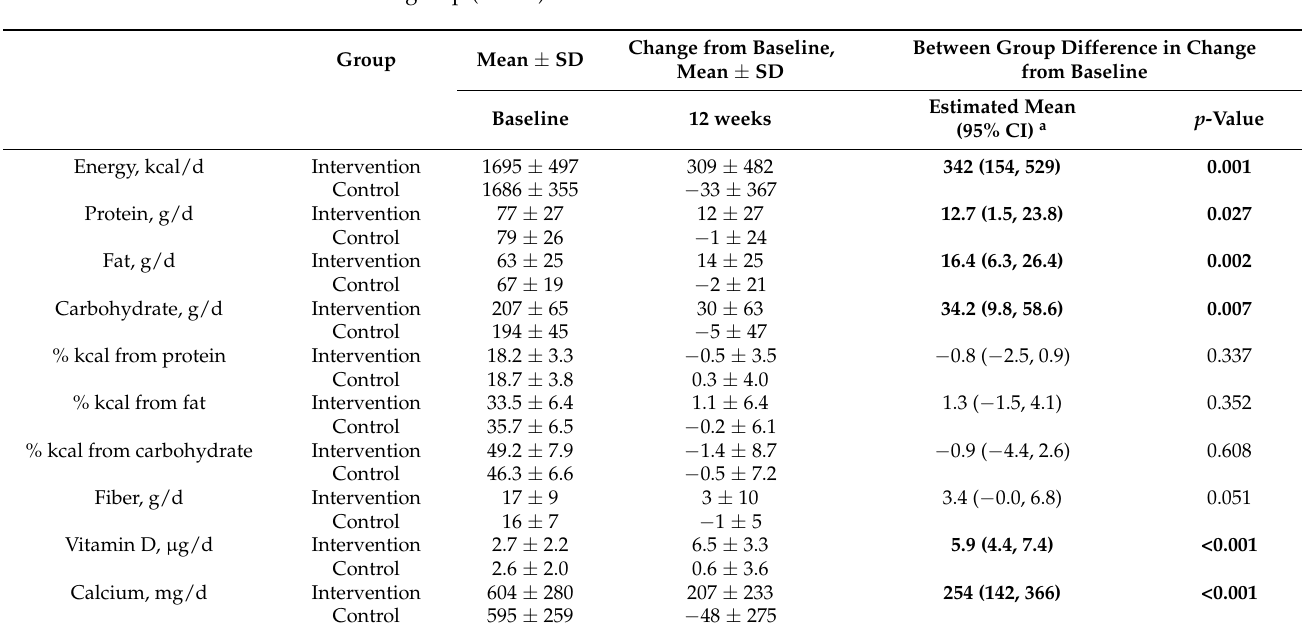
− 48 ± 275 CI, confidence interval. Data are presented as mean ± SD. Bold values represented p < 0.05. a Represents group difference (intervention group minus control group) in 12-week change estimate (12-week minus baseline). Estimated mean (95% CI) was derived from independent-sample t